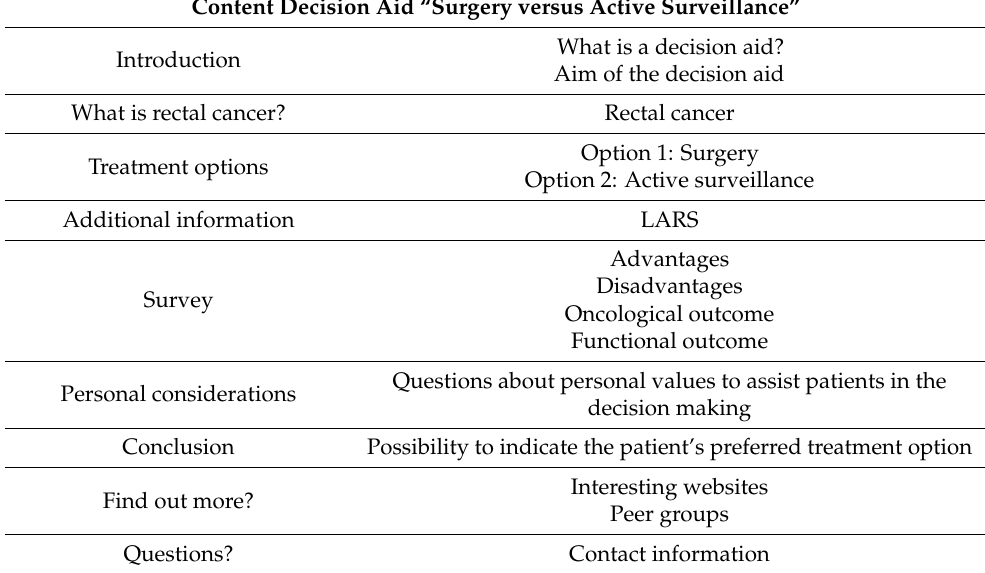
Table 2. Content decision